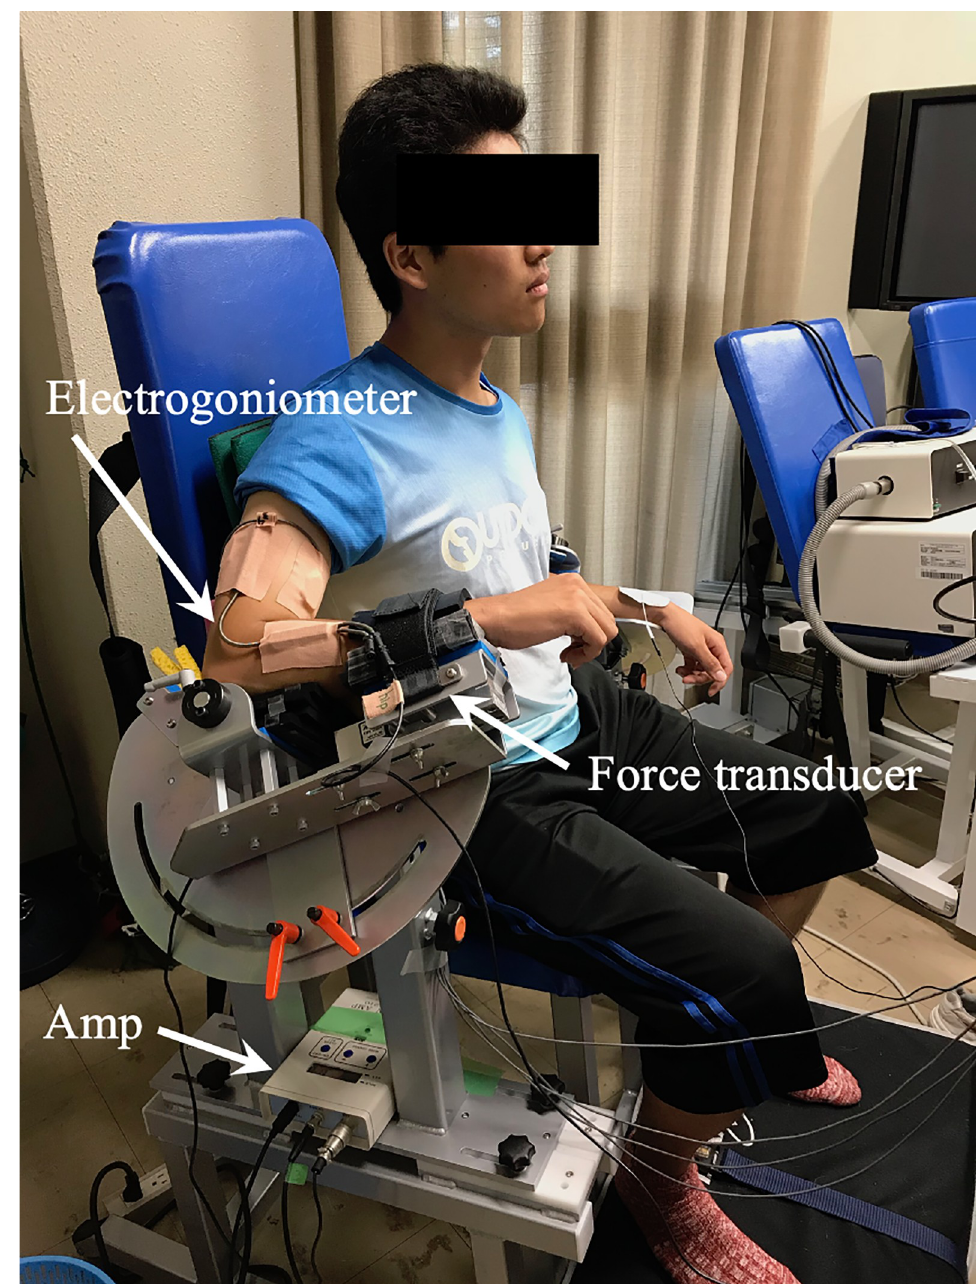
Fig 1. Experimental setup of elbow extension tasks and placement of electrodes on the medial, lateral, and long heads of the triceps brachii. Amp, amplifier.